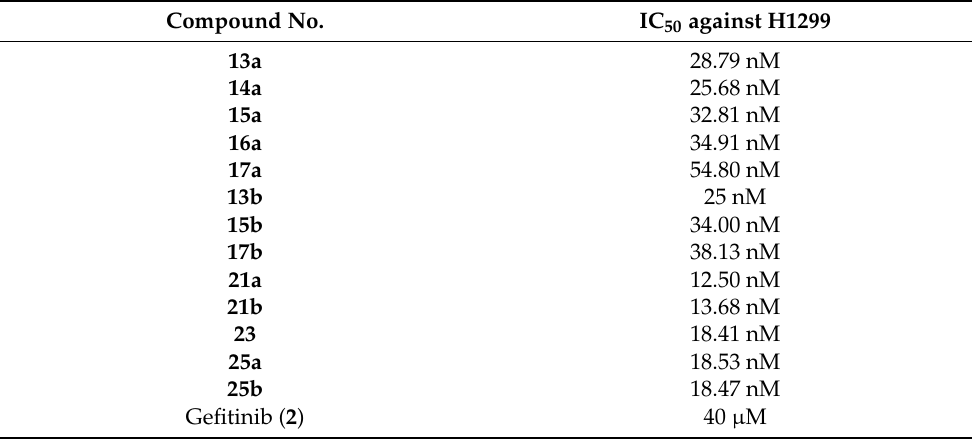
Table 1. In vitro cytotoxic activity of compounds ( 13 – 25a,b ) against non-small cell lung cancer (NSCLC) cell line